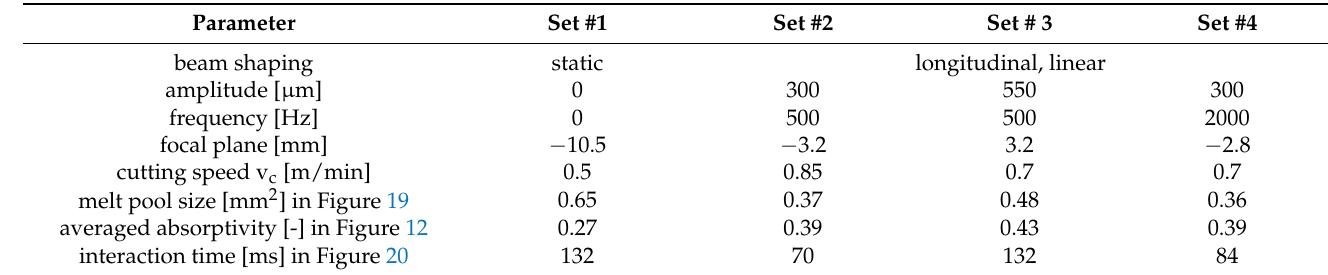
Table 5. Overview of cutting speed, melt pool size, absorptivity, and interaction time for static beam shaping and longitudinal, linear beam